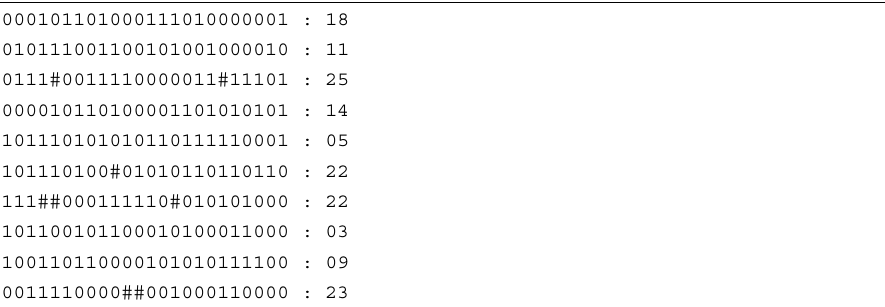
Table 1 A population of LCS classifier rules in state-action